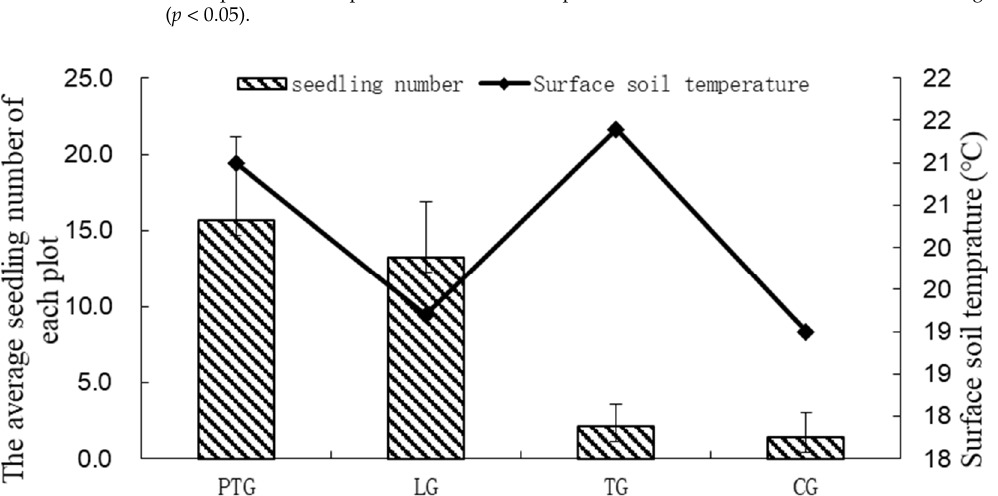
Figure 5. Effect of light intensity on the number of emerged seedlings in the soil seed bank under different photo-thermal treatments.